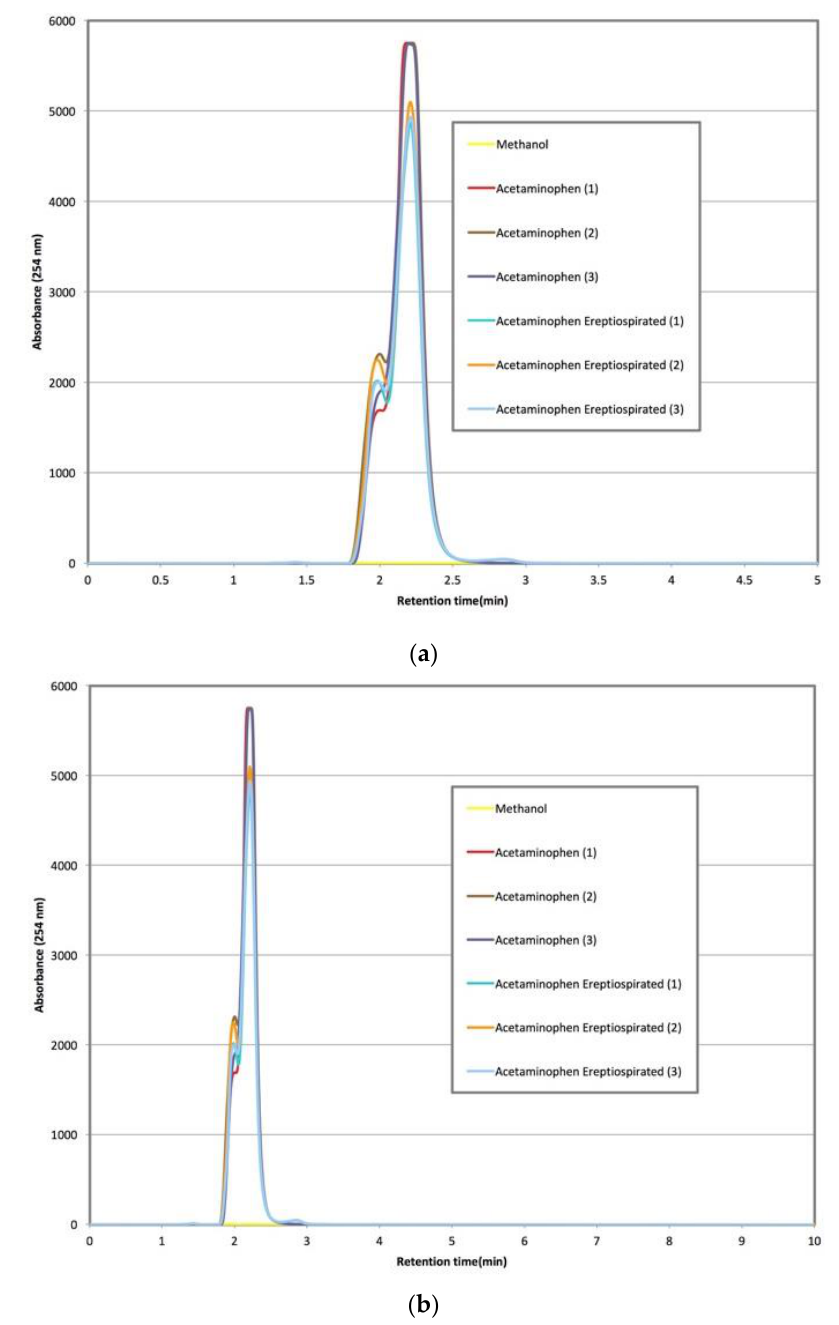
Figure 3. HPLC data for methanol, acetaminophen, and acetaminophen collected after ereptiospiration. Image on the top ( a ) shows the chromatogram for the time period of 0–5 min, while the image on the bottom ( b ) shows the same chromatogram for the full run time of 0–10 min. Methanol (yellow trace) does not show a peak while the ereptiospirated acetaminophen and acetaminophen from the reagent container showing peaks with the same retention time and very similar peak shape and relative heights, indicated that no chemical change was detected [16]. Note that in reference [16] using similar HPLC conditions, increased peak width change is considered to be an especially good indicator of chemical changes.